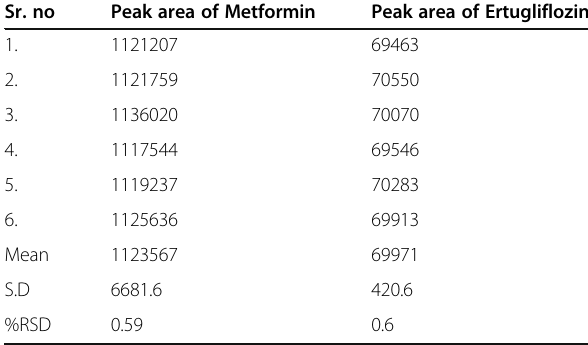
Table 2 Precision results of Metformin and Ertugliflozin Sr. no